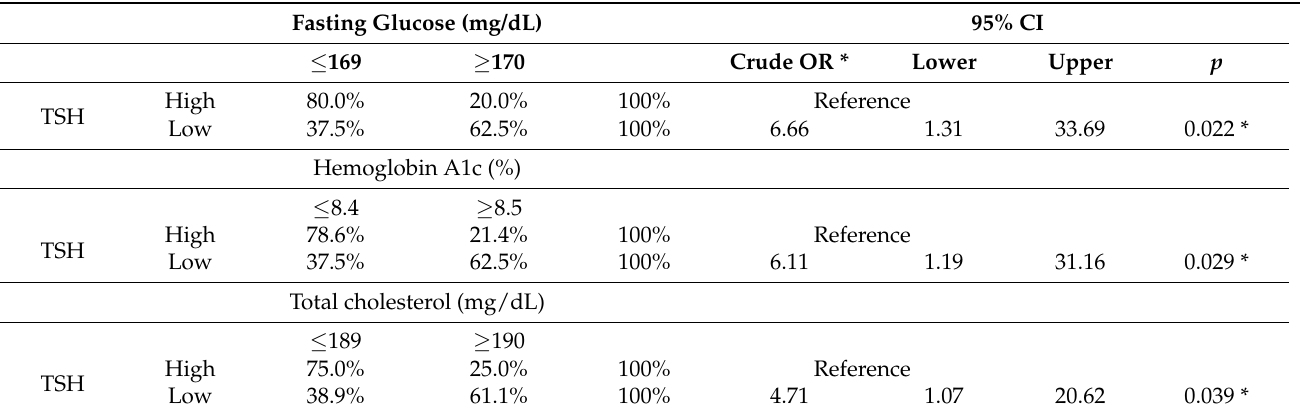
Table 5. TSH as a Predictor for Glucose and Lipid Control in Type 2 Diabetic Patients ( n = 34) † ¶ . Fasting Glucose